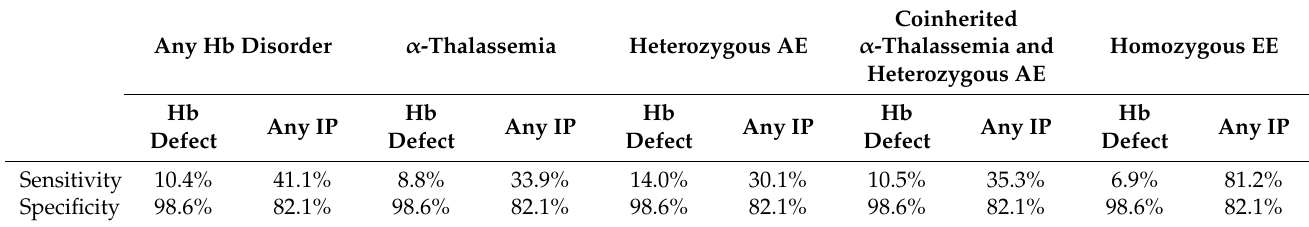
Table 3. Sensitivity and specificity values classified by women who were flagged for the “Hb defect” IP message and by women who were flagged by any IP message